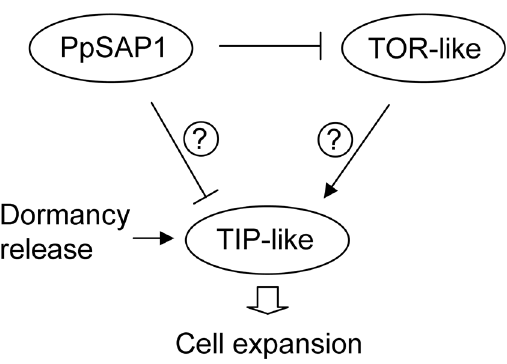
Figure 11. Proposed model of transcriptional interactions between PpSAP1 , TOR -like and TIP -like. Transcriptional activation is labelled with an arrow. Transcriptional repression is labelled with a T-shaped